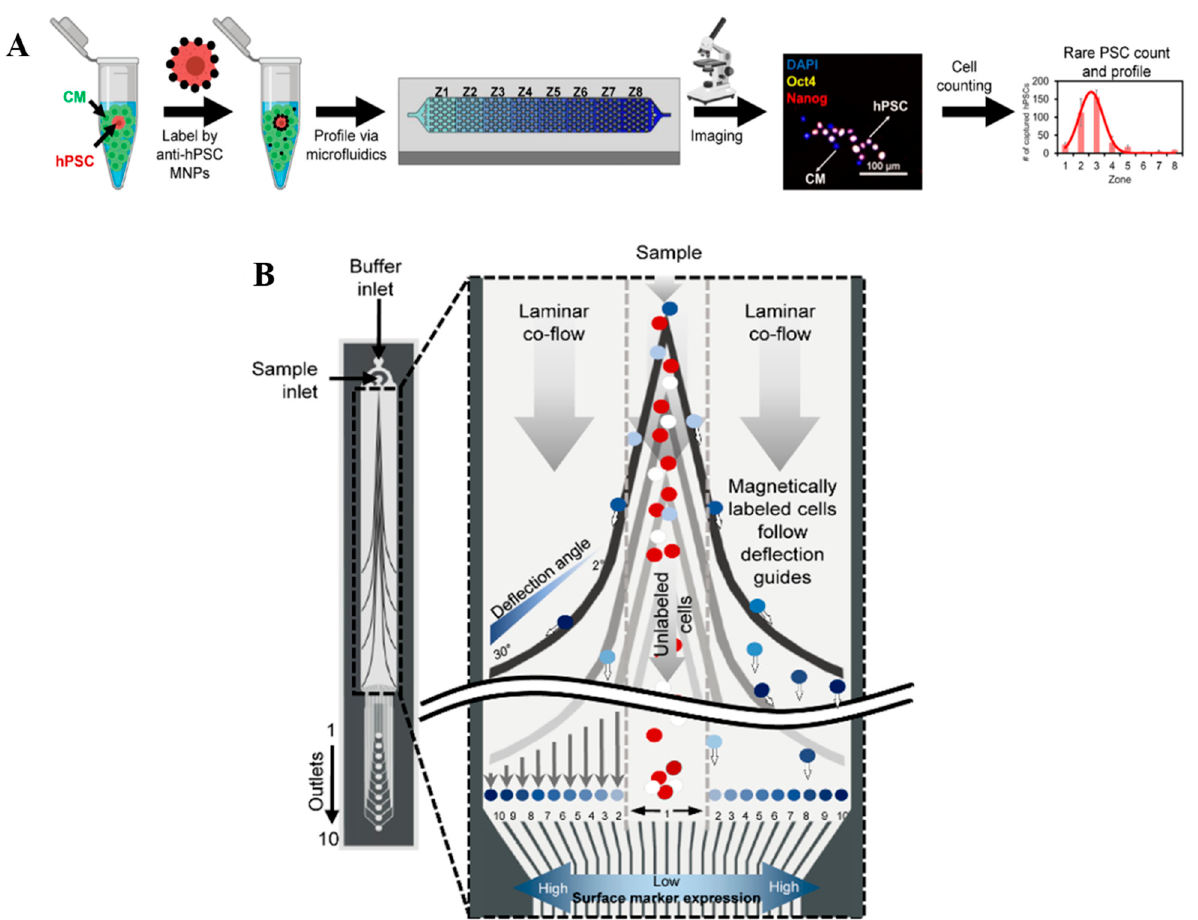
Figure 6. ( A ) Stem cell isolation and sorting with first-generation MagRC device and nanoparticles [49]. ( B ) Schematic representation of second-generation MagRC design for cell sorting [50]. It should be noted that while this design is not CRISPR based, the same technology is applied in the CRISPR- based versions. Figures reprinted with permissions.